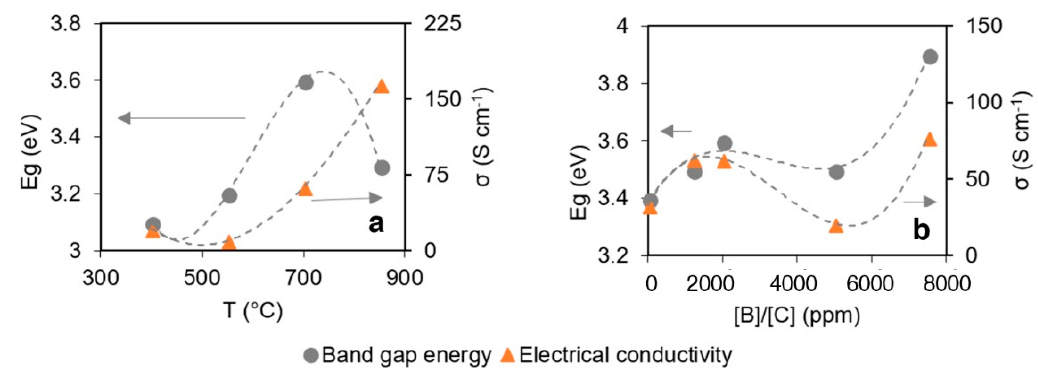
Figure 6. ( a ) Optical bandgap and electrical conductivity for B ‐ CNW growth at 400 °C, 550 °C, 700 °C, and 850°C at a 2000 ppm [B]/[C] ratio; ( b ) optical bandgap and electrical conductivity for B ‐ CNW growth at 0, 2000, 5000, and 7500 ppm [B]/[C] at 700 °C.